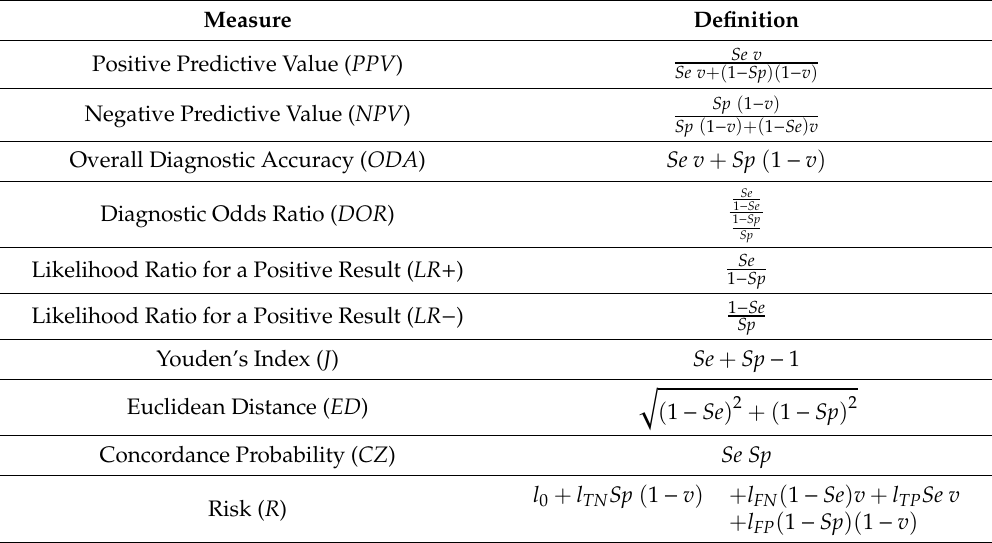
Table 3. Definitions of diagnostic accuracy measures against sensitivity and specificity.